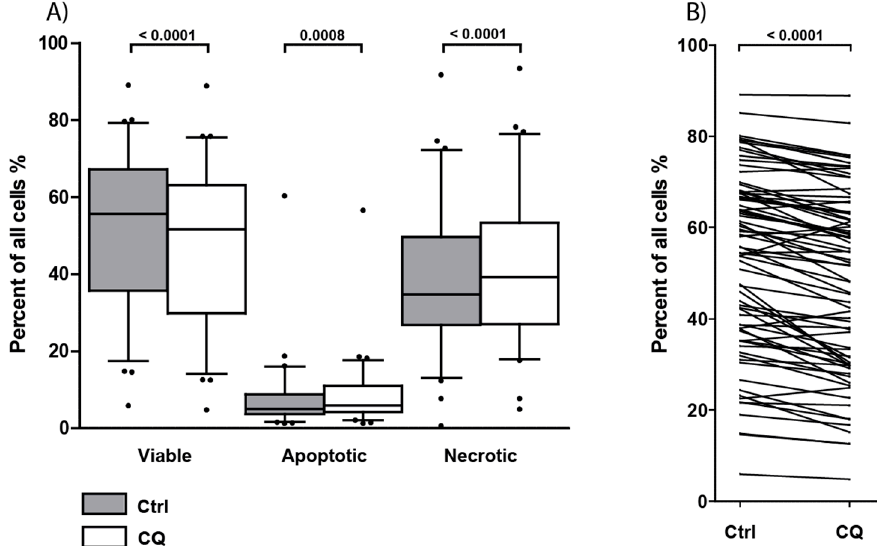
Figure 5. Effect of chloroquine (CQ) 5 µM on primary AML cell viability, apoptosis, and necrosis after 48 h of culture. Primary cells from 78 consecutive AML patients were cultured with or without 5 µM CQ for 48 h before viability, early apoptosis, and late apoptosis/necrosis were determined by flow cytometry using the AnnexinV/Propidium iodide (PI) assay. ( A ) The figure shows the overall results for the 72 patients with more than 5% viable cells in drug-free controls. The percentage of viable (AnnexinV − PI − ), early apoptotic (AnnexinV + PI - ) and end stage apoptotic and necrotic cells (AnnexinV + PI + ) were determined in patient samples after treatment with 5 µM CQ (white boxes) and after culture in medium alone (gray boxes) for 48 h. Data are presented as median levels, 25/75 percentiles, and 5/95 percentile whiskers, • = outliers. The overall effect when analyzing samples pairwise was examined; and treatment with 5 µM CQ significantly decreased viability ( p -value < 0.0001) and increased apoptosis and late apoptosis/necrosis ( p- values = 0.0008 and <0.0001, respec- tively; Wilcoxon signed rank test). ( B ) The percentage of viable primary AML cells cultured in me- dium alone compared to treatment with 5 µM CQ for 48 h. This figure presents the viability results for each individual patient. A wide range of cell viability is seen among patients, with a significant decrease in viability after treatment with 5 µM CQ ( p -value = 0.0001).